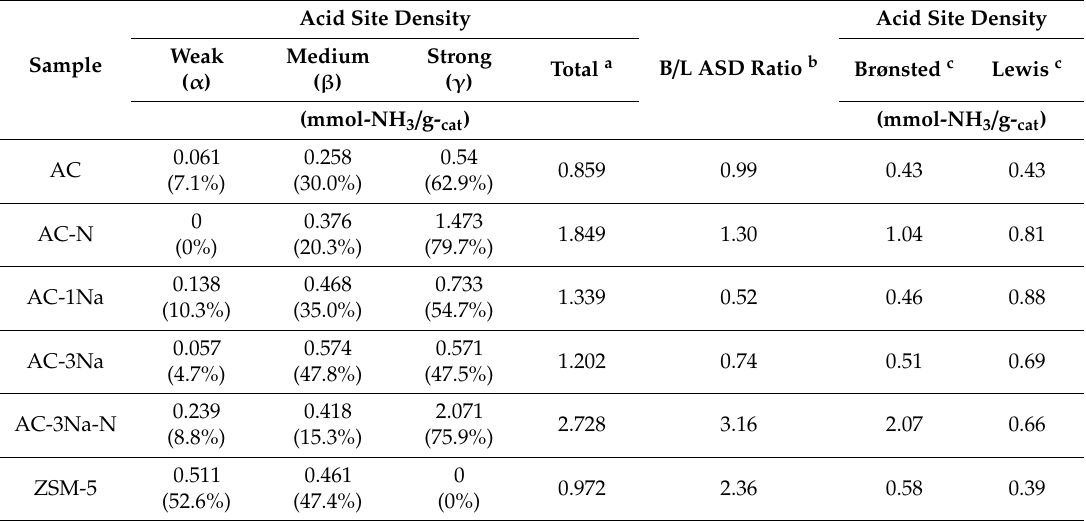
Table 2. Acid site densities of ACs and ZSM-5